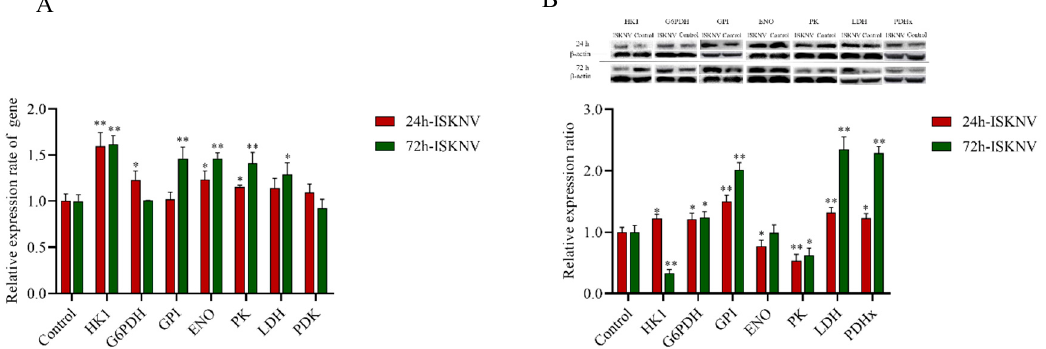
Figure 2. The ISKNV infection altered the glucose metabolism in CPB cells. ( A ) The ISKNV infection promoted the transcription of relative genes of glucose metabolism. ( B ) Western blot analysis of relative genes of glucose metabolism expression in control- and ISKNV-infected CPB cells. At the indicated time points after the ISKNV infection, total protein was extracted from CPB cells and subjected to Western blotting. β -Actin was used as an internal control. For each target protein, three to six parallel samples were pooled as biological replicates. * p < 0.05; ** p <